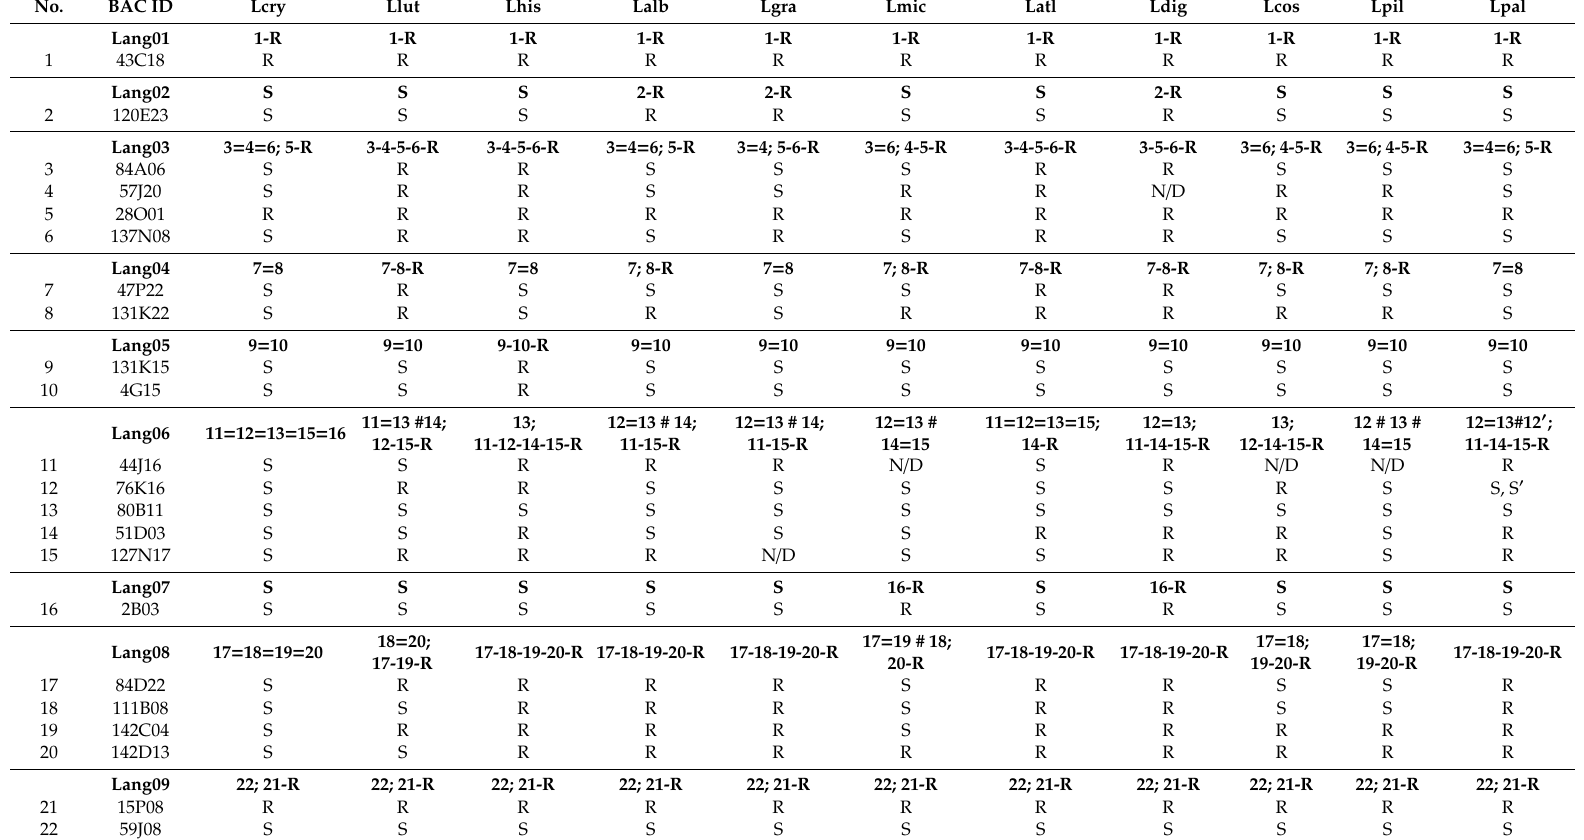
Table 3. Characteristics and localizations of the BAC clones used for the comparative